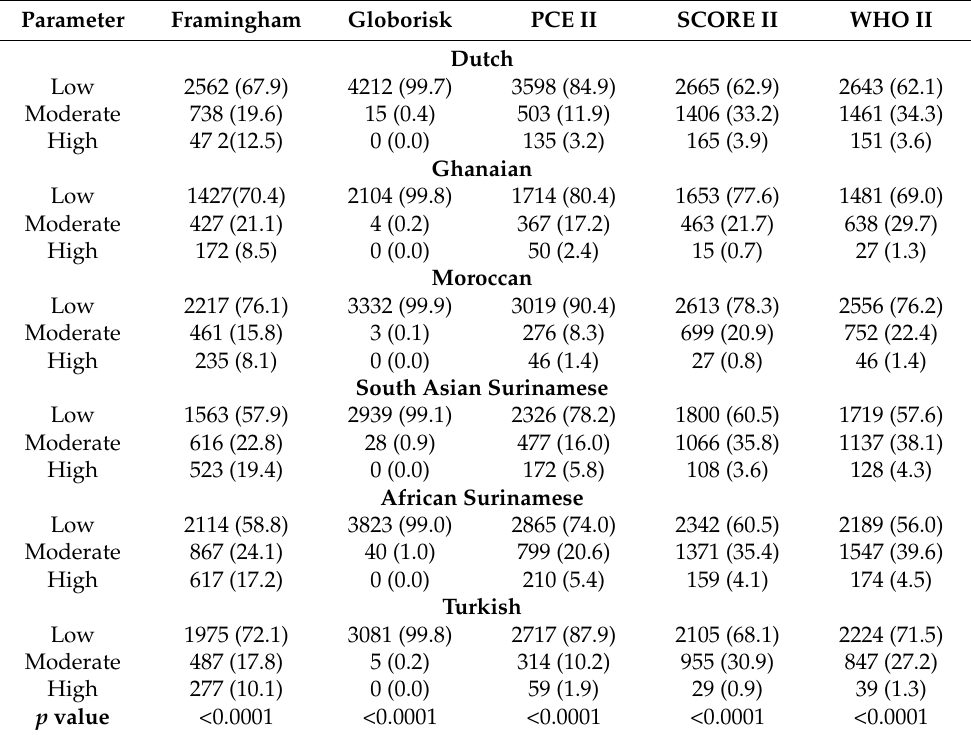
Table 3. CVD Risk classification among ethnic groups living in the Netherlands using laboratory- based cardiovascular risk scores.